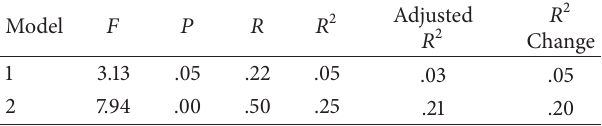
Table 5: Results of regression analysis for overall contribution of four vocabulary knowledge subcomponents to reading comprehen- sion after motivation and self-efficacy were controlled ( 𝑁 = 124).